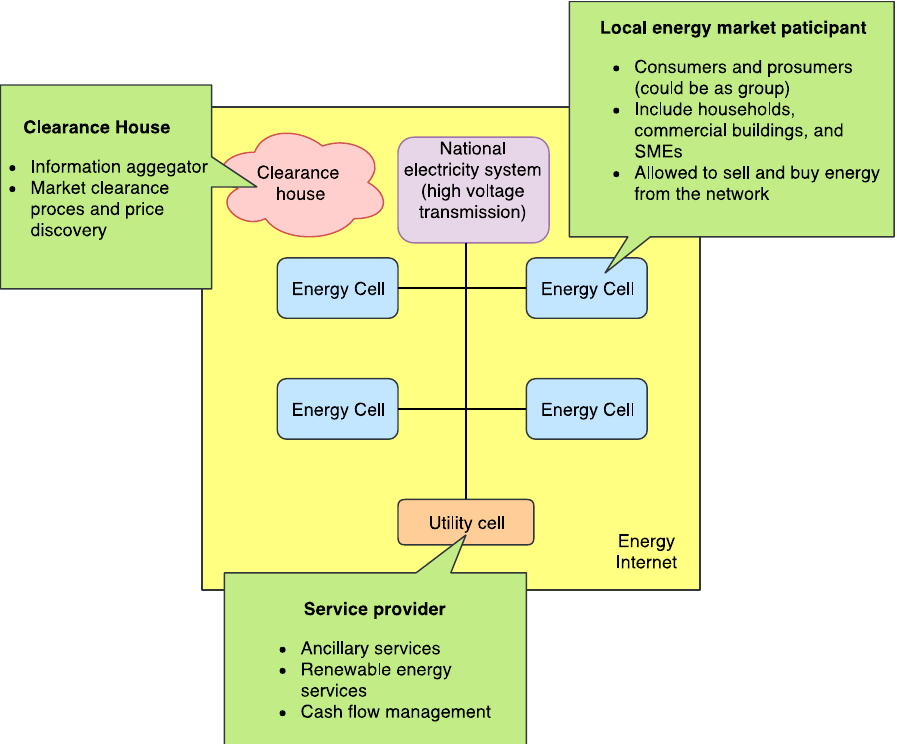
Figure 2. Interactive agents in Energy Internet architecture.